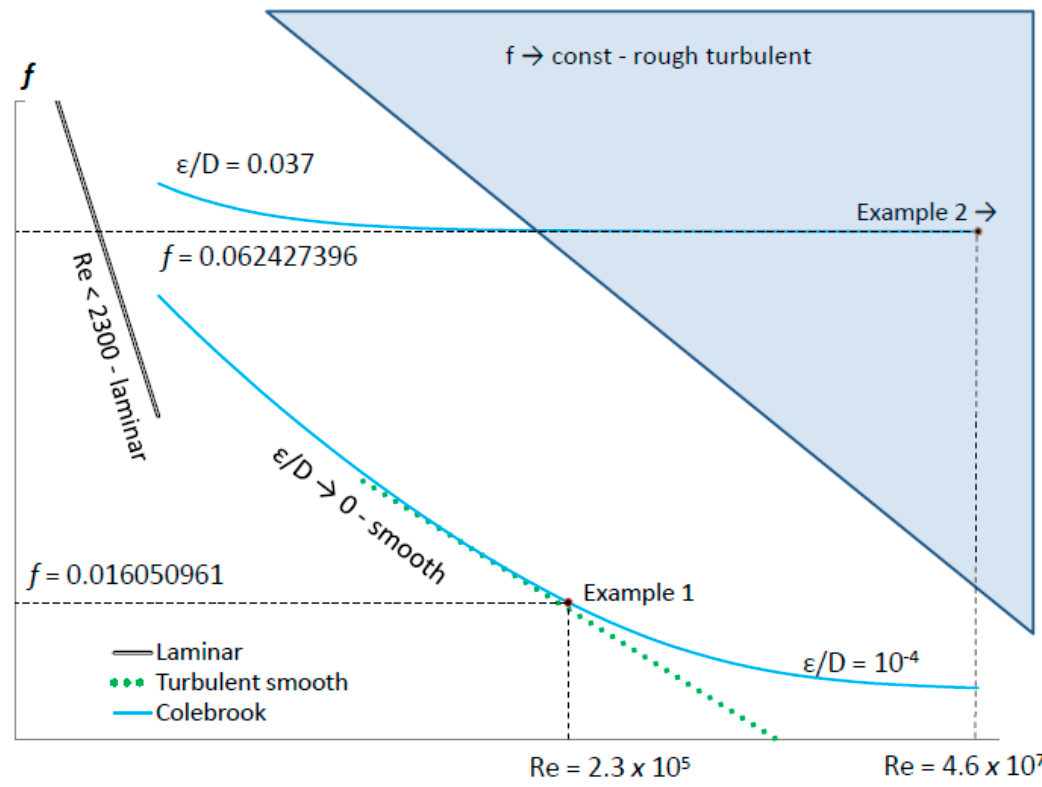
Figure 1. Position of the two presented examples with respect to the hydraulic regimes (laminar, transition to turbulent, and turbulent, which includes smooth, smooth to rough, and fully turbulent rough regime).